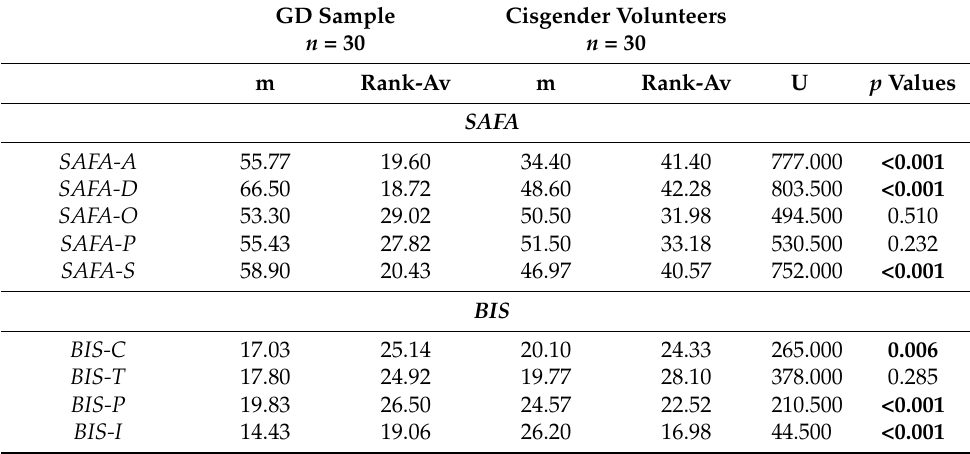
Table 2. Mann–Whitney comparison of SAFA, BIS, and DERS scales between GD sample and cisgender